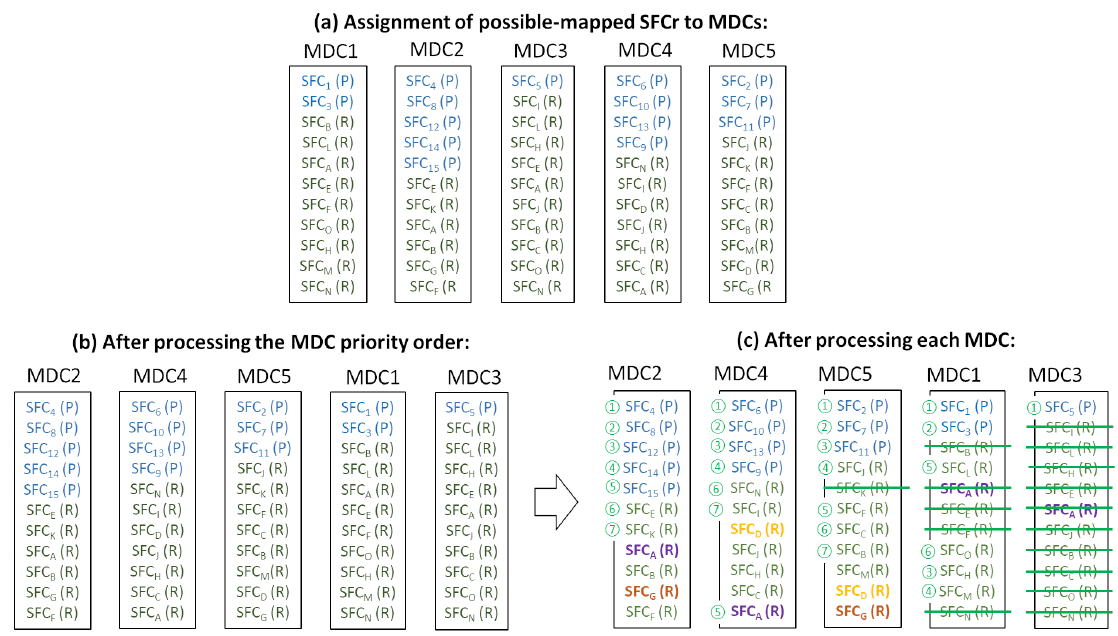
Figure 2. Example of priority-based mapping algorithm execution. Five MDCs and a set of 30 SFCrs are considered. It is assumed that the MDCs have CPU and memory resources to accommodate seven SFCs at most. ( a ) shows the assignment of possibly mapped SFCrs to each MDC taking into account the delay restrictions. The SFCrs that are only assigned to one possible MDC (P-SFCrs) are shown in blue and the R-SFCrs in green. ( b ) shows the MDC processing priority order (from left to right). Finally, ( c ) shows the result of the mapping algorithm. The SFCrs with a number on the left are mapped ones. The SFCrs without a number and that are not crossed out are pending SFCrs that will be considered in subsequent MDCs, and crossed out SFCrs indicate SFCrs that have been already mapped in previous